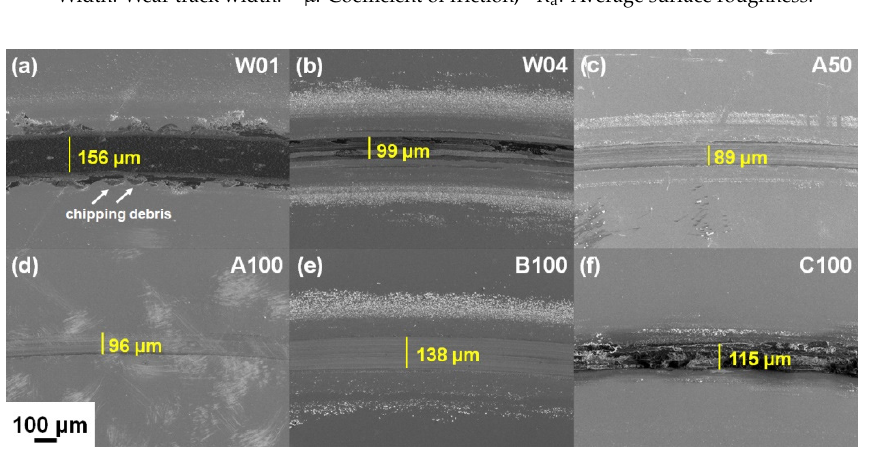
Figure 10. Wear scars of the ( a ) W01, ( b ) W04, ( c ) A50, ( d ) A100, ( e ) B100, and ( f ) C100 films.